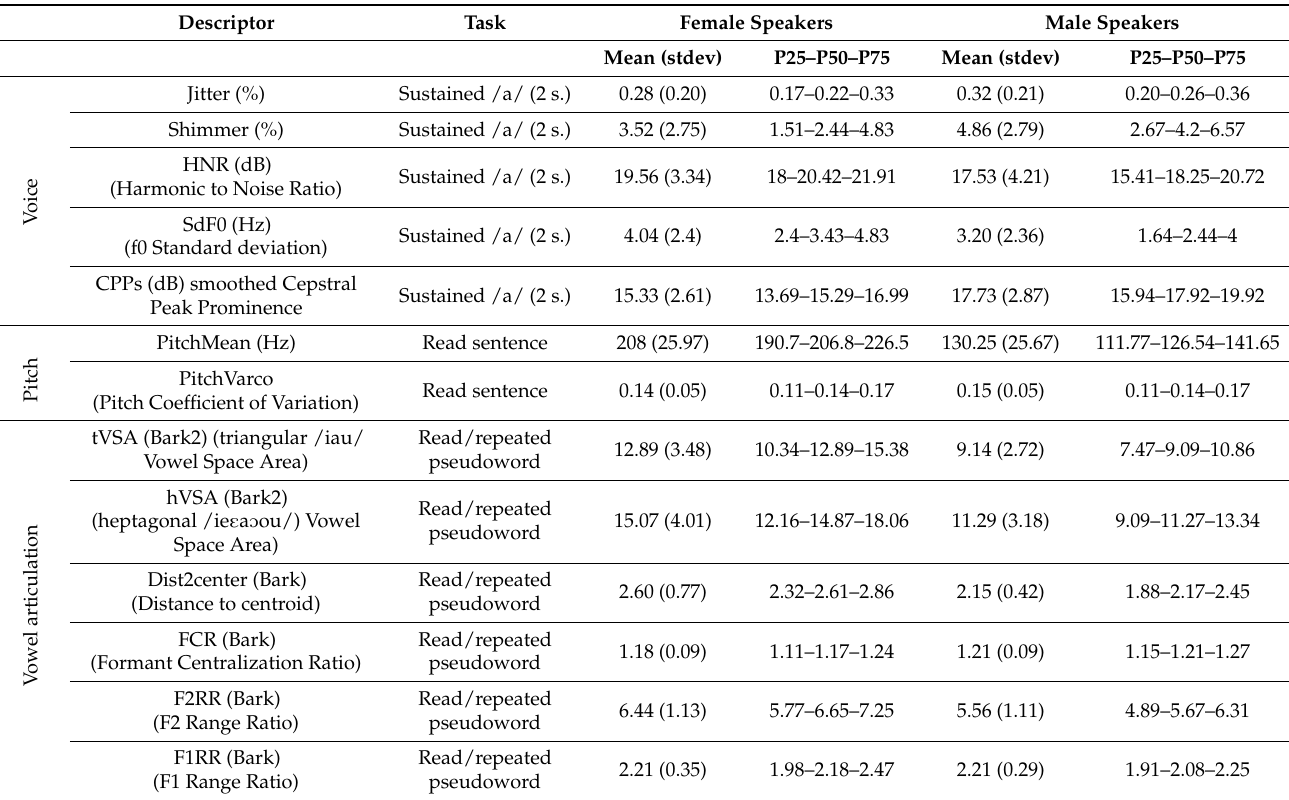
Table 2. Summary of the 22 speech descriptors and descriptive statistics per sex (mean (standard deviation)); 25th percentile (P25); median = 50th percentile (P50) and 75th percentile